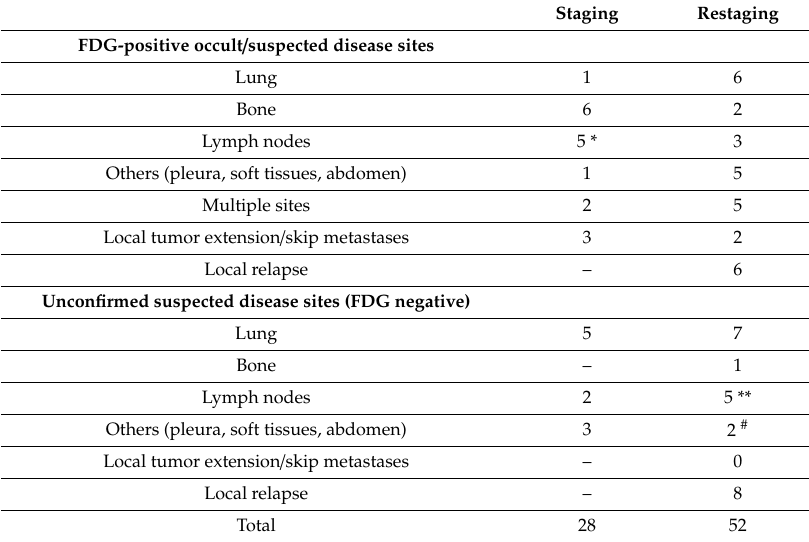
Table 2. Reasons for change in patient management due to results of 18 F-PET / TC over conventional imaging (CT and MRI).